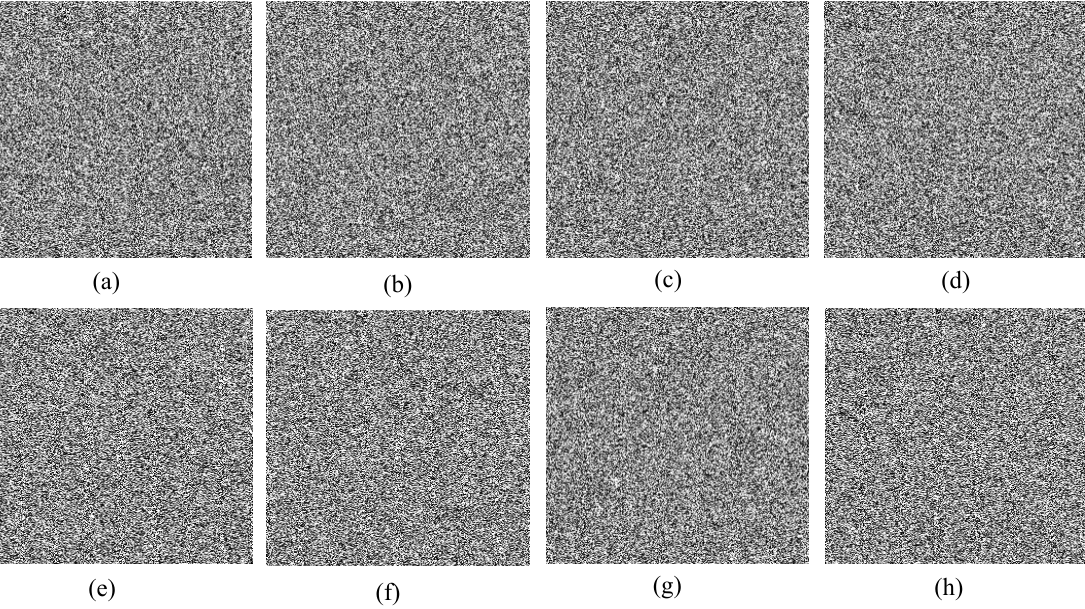
Figure 13. ( a – h ) The eight ciphertext images after adding salt and pepper noise with 0.1 density. Table 4. SSIM of eight images with different salt and pepper noise